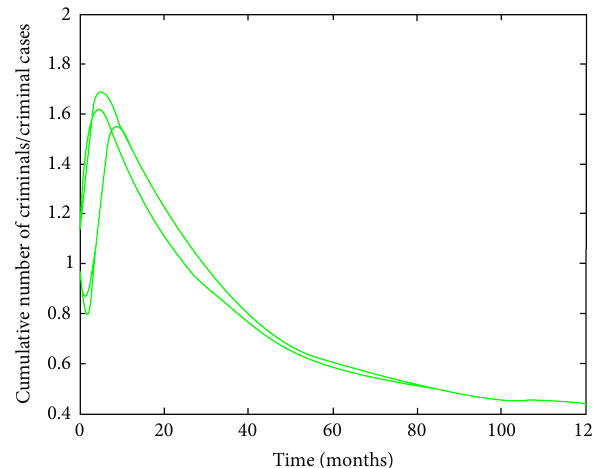
Figure 9: Simulation of model (4) using various initial conditions, showing cumulative number of crime/criminal cases when and . Other parameter values used are as given in in Table 3. 𝛽 2 = .05